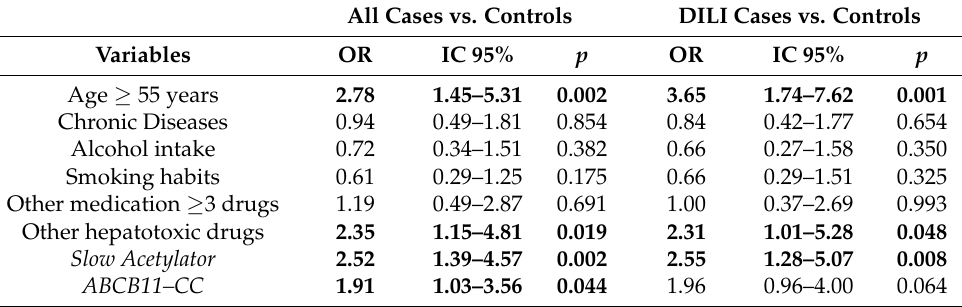
Table 4. Results of logistic multivariate analysis for all cases and DILI. All Cases vs. Controls DILI Cases vs.